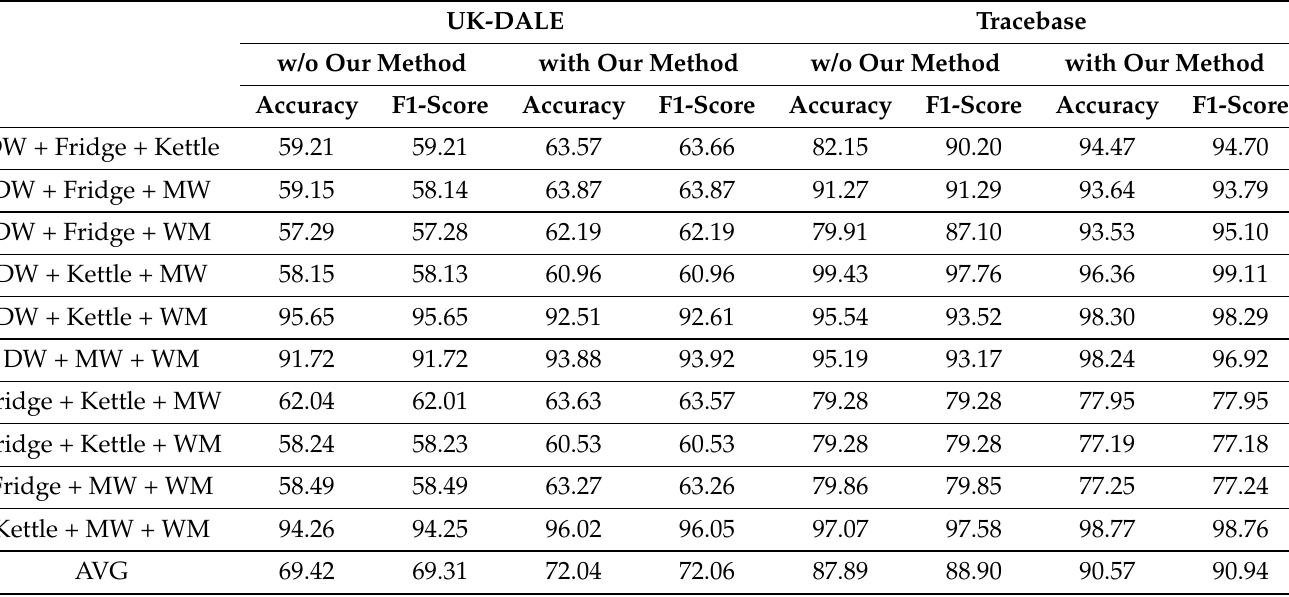
Table 7. The results of combinations of three appliances with VDOCNN.